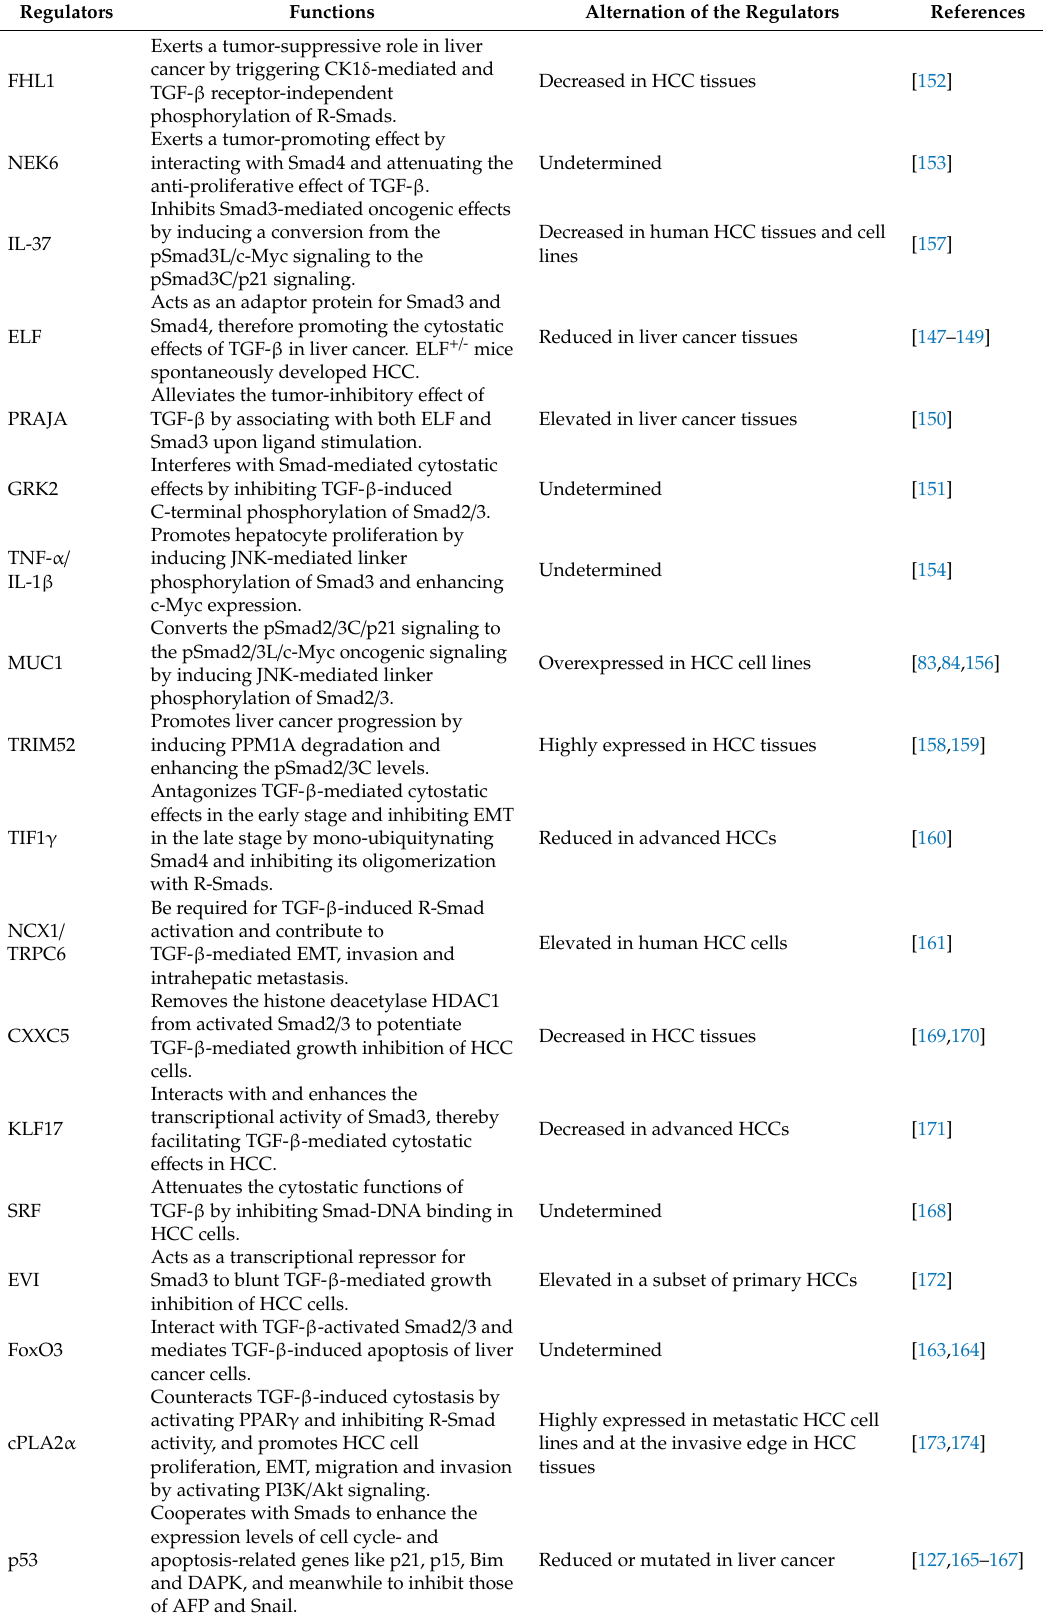
Table 2. Regulation of Smad Proteins in Liver